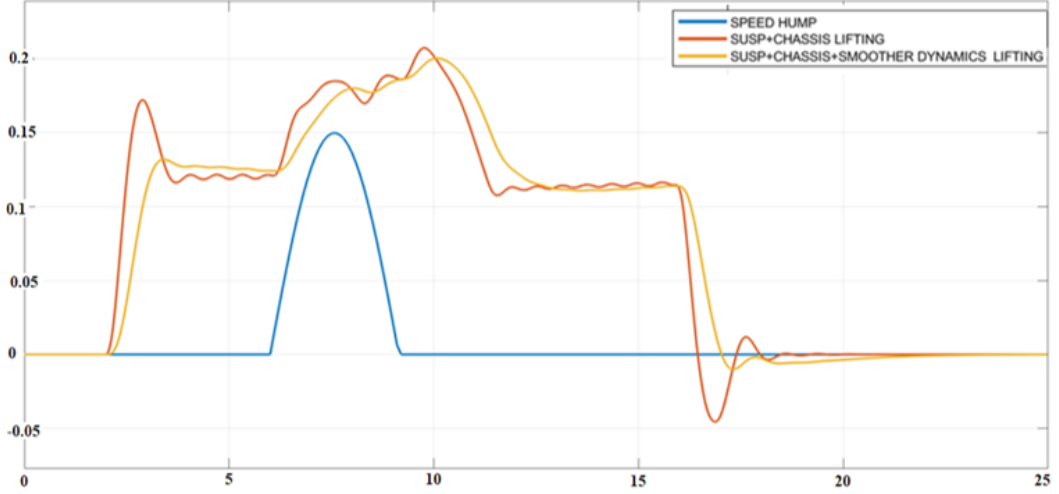
Figure 9. The proposed solution (red) and an ulterior version of it (yellow) could accomplish the task of lifting the car in advance (at Second 2, i.e., 4 s before reaching the bump). Besides, from Seconds 9–16, the car remains up for safety, and the return to its original height transits softly during all the vertical displacement. Notice that the return to its original position (zero level) was performed gently, and the hump was